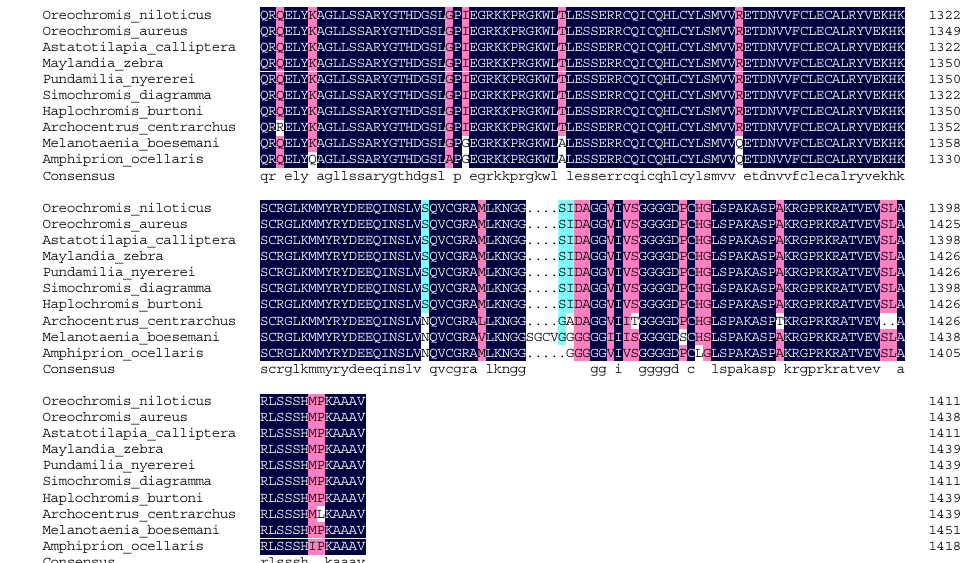
Figure 2. Multiple alignments of JARID2B amino acid sequence in Nile tilapia and other species. The identical amino acid residues are shaded in dark blue-grey. Pink shade indicates highly conserved amino acid residues and the amino acid residues only in one or two species differed from those of other species. The predicted JmjN domain, BRIGHT and ARID domain, and JmjC domain are marked with red overlines. The phylogenetic tree constructed using MEGA 7.0 revealed that JARID2B and JARID2A could be clustered in respective clades. The JARID2B in Nile tilapia gathered into a cluster with the one in O. a. and later with H. b. and S. d. (Figure 3), showing that the JARID2B in Nile tilapia had the highest homology with the one in O. a. .